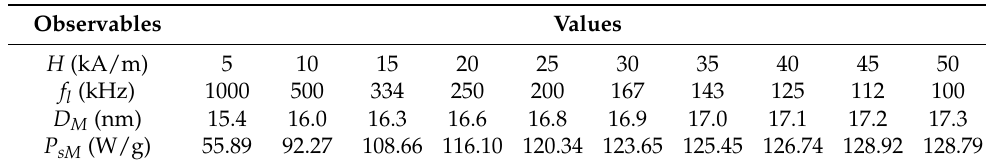
Table 3. The values of the maximum specific loss power P sM determined for the critical